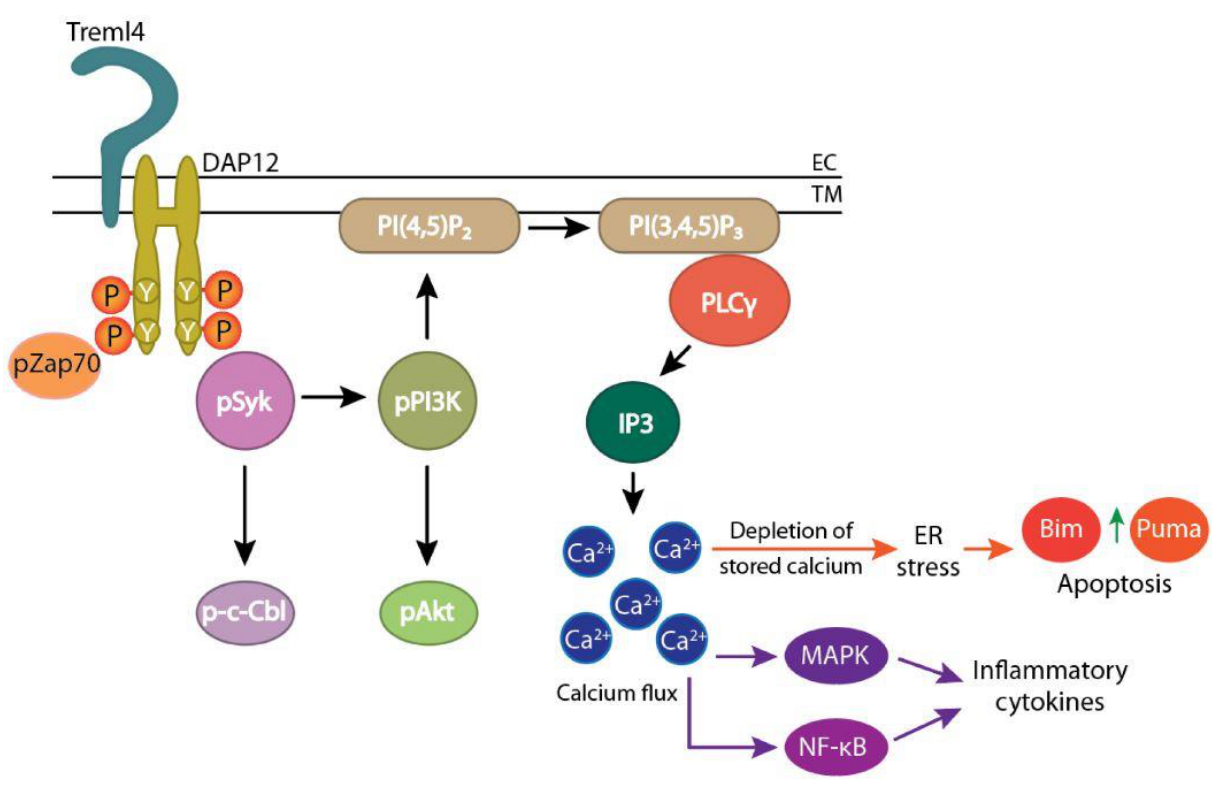
FIGURE 2: TREML4 regulates both the inflammatory phase and the immune suppression phase in polymicrobial sepsis. The schematic depicts the possible players